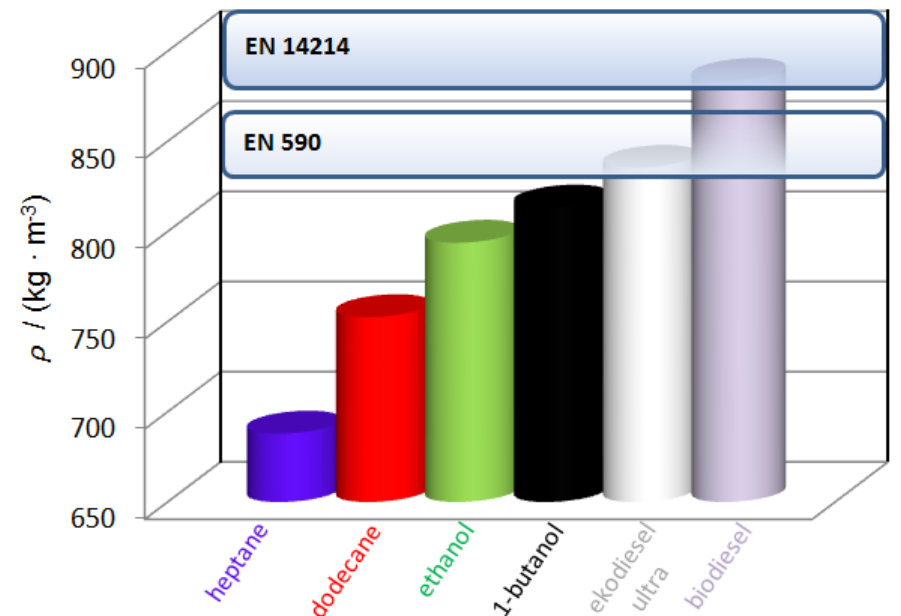
Figure 12. Comparison of the density at 288.15 K of heptane [36,37], dodecane [38], ethanol [36,37], 1-butanol (this work), ekodiesel ultra [12], biodiesel [12] with norm EN 590 for diesel and EN 14214 for biodiesel.